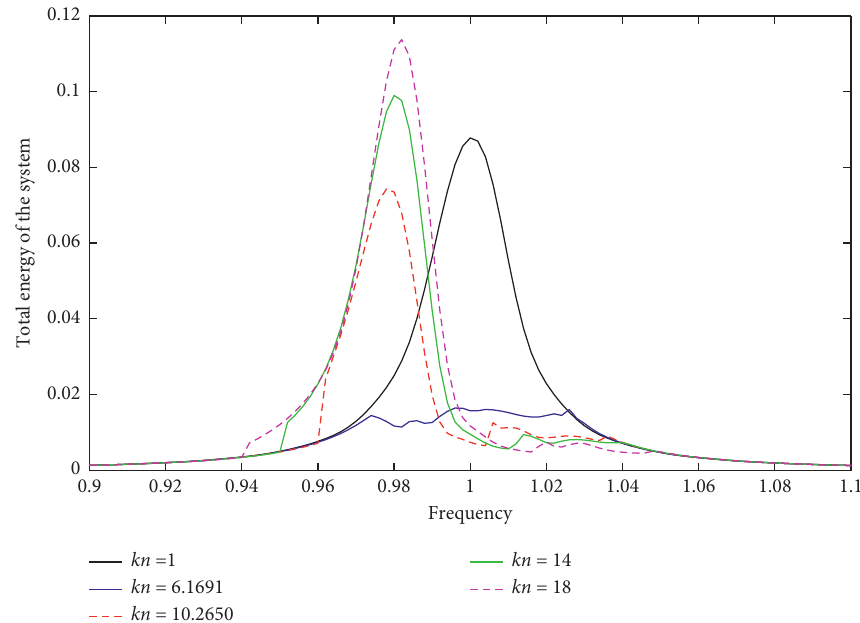
Figure 22: Average total energy of the system with respect to excitation frequency.